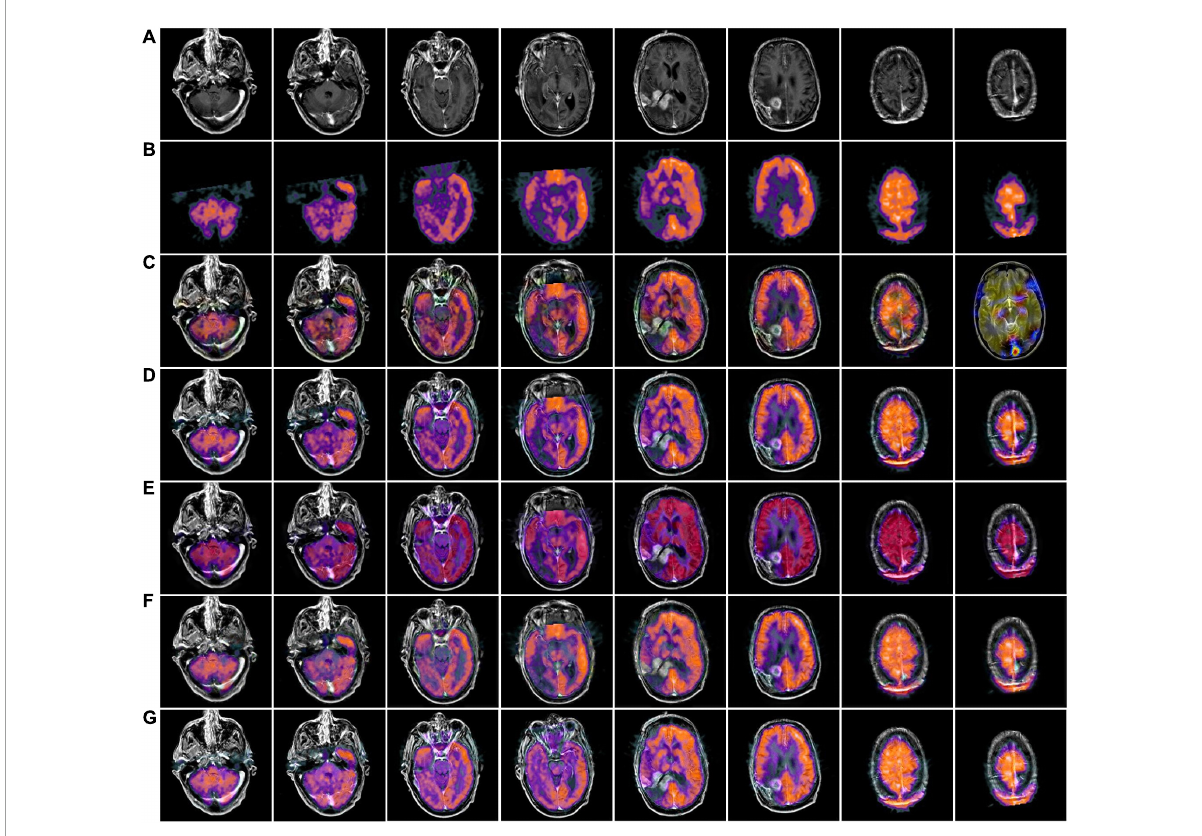
FIGURE4 MRI-PET fusion images obtained by five methods in Paras1. (A) Magnetic resonance imaging (MRI) source image; (B) positron emission tomography (PET) source image; (C) nonsubsampled contourlet (NSCT) fusion result; (D) non-subsampled shear wave transform (NSST) fusion result; (E) guided filter ng fusion (GFF) fusion result; (F) Laplacian redecomposition (ReLP) fusion result; (G) fusion result of the proposed